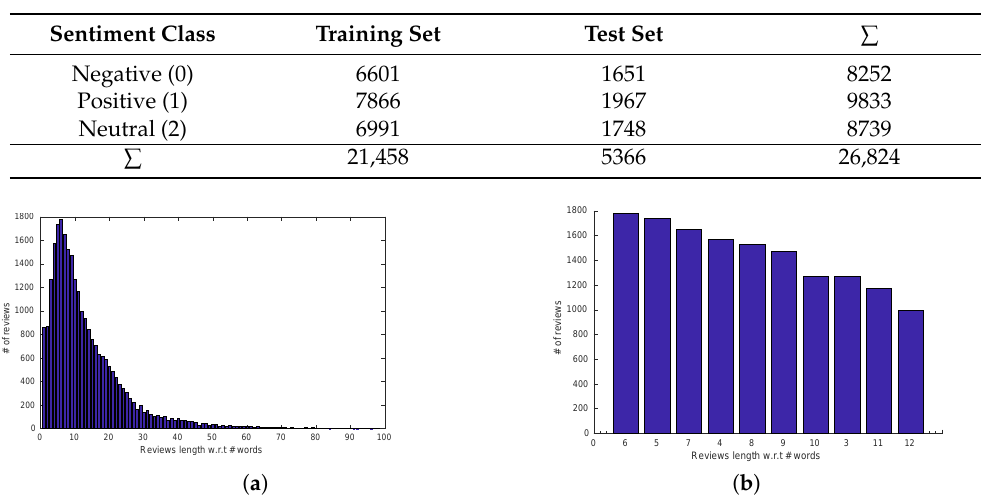
Table 3. RUECD dataset description; there are a total of 26,824 reviews divided into two sets, i.e., training set and test set.